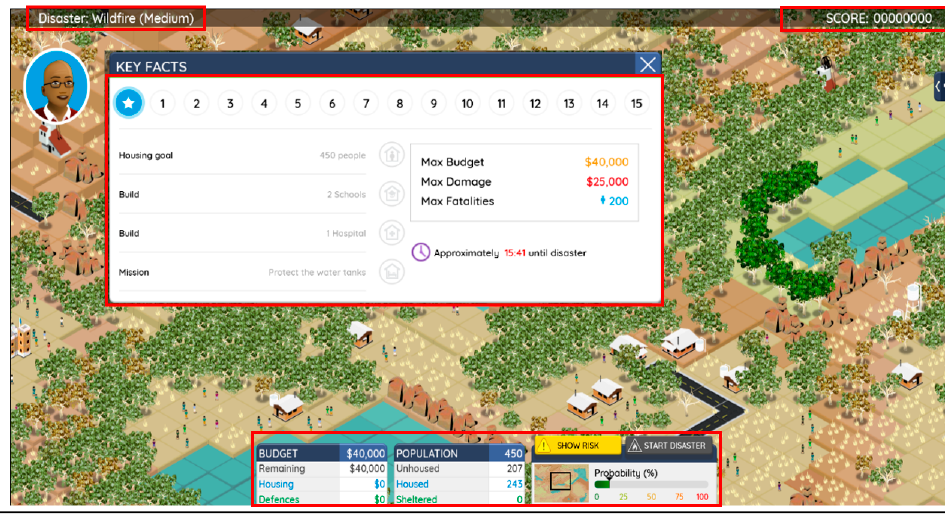
Figure 4. Overview of the gaming platform.